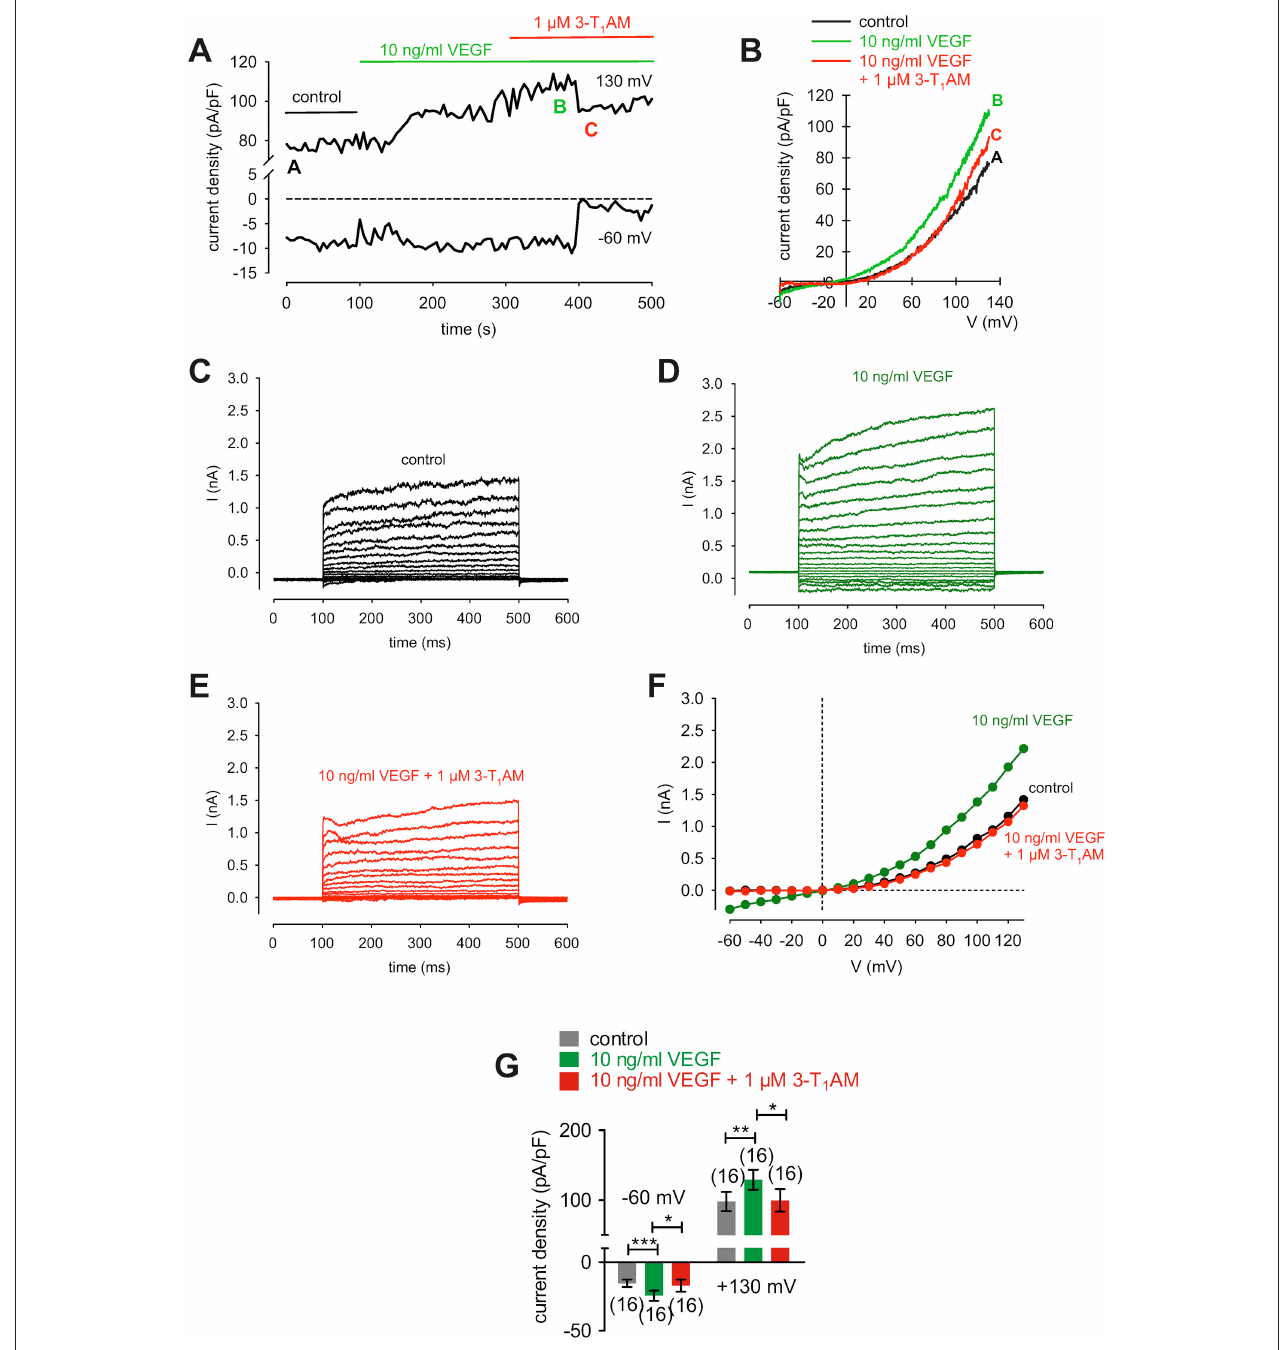
FIGURE 12 | 3-T 1 AM suppresses VEGF-induced increases in whole-cell currents in HCK. (A) Time course recording showing the current increases induced by 10ng/ml VEGF and current density levels after adding 3-T 1 AM (1 µ M). There was a delayed increase and decrease of whole-cell currents, respectively. (B) Original traces of VEGF-induced current responses to voltage ramps. Current densities are shown before application (black labeled as A), during application of VEGF (green labeled as B), and after addition of 3T 1 AM (red labeled as C). Current densities as function of voltage were derived from the traces shown in (A) . Notably, there was a decrease of VEGF-induced in- and outward currents in the presence of 3-T 1 AM. (C) Whole-cell currents under control conditions induced by depolarization from − 60 to 130mV in 10mV steps (400ms). (D) Increased whole-cell currents (green traces) in the presence of 10ng/ml VEGF. (E) Decreased whole-cell currents (red traces) in the additional presence of 1 µ M 3-T 1 AM. (F) Effect of VEGF and 3-T 1 AM summarized in a current/voltage plot [I-V plot, data obtained from (C–E) ]. The black trace (filled circles) was obtained under control conditions. The green trace was obtained in the presence of 10ng/ml VEGF and the lower red trace in the additional presence of 3-T 1 AM. An inhibitory effect could be observed. (G) Summary of the experiments with VEGF and 3-T 1 AM. The asterisks (*) indicate statistically significant differences of in- and outward currents with and without 3-T 1 AM ( n = 16; p < 0.05 at the minimum; paired tested).